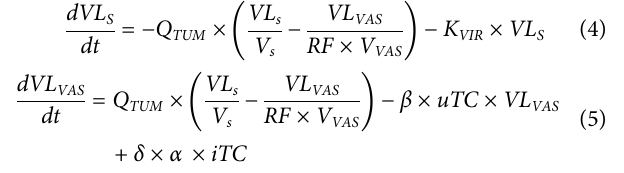
Frontiers in Pharmacology |